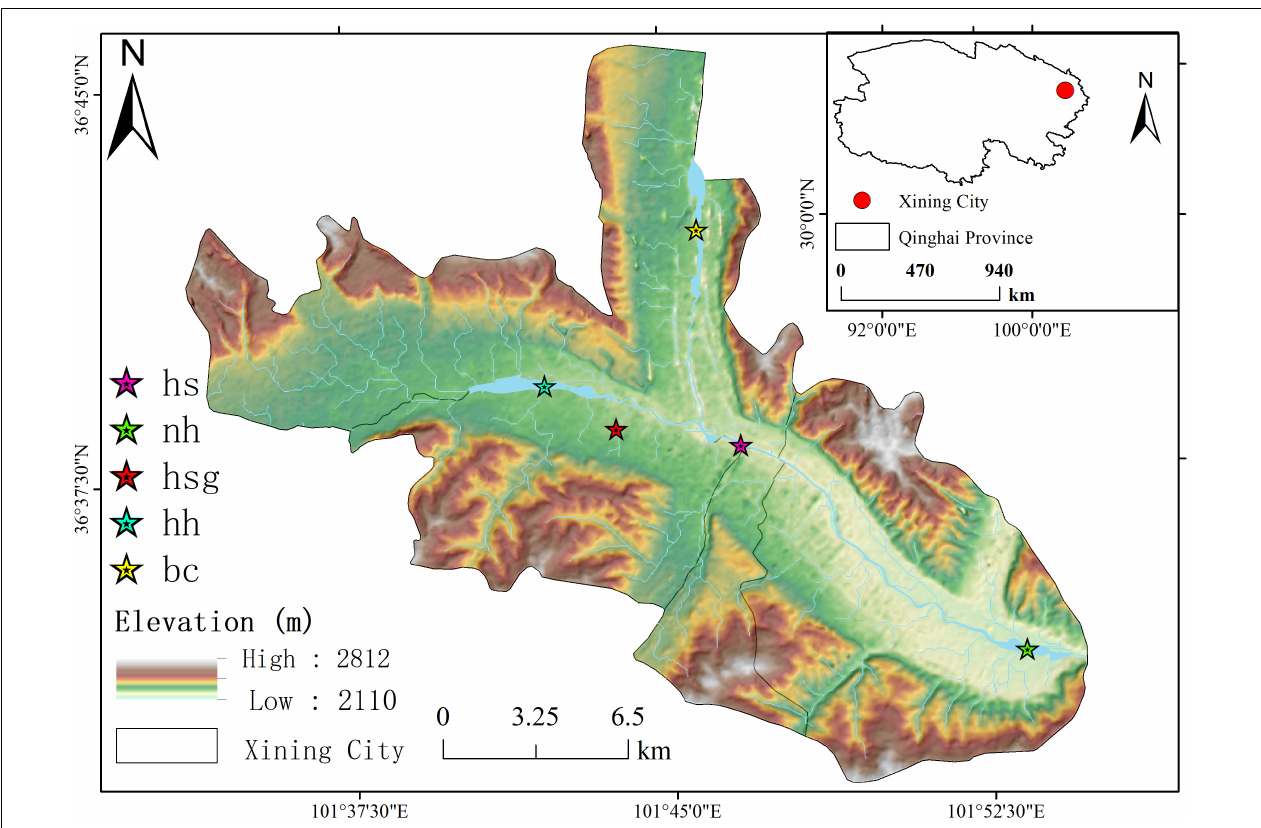
FIGURE 1 | The location of the Huangshui National Wetland Park. Haihu wetland (36 ◦ 38 (cid:48) 57 (cid:48)(cid:48) –36 ◦ 39 (cid:48) 29 (cid:48)(cid:48) N, 101 ◦ 40 (cid:48) 24 (cid:48)(cid:48) –101 ◦ 43 (cid:48) 24 (cid:48)(cid:48) E). Huoshaogou wetland (36 ◦ 38 (cid:48) 15 (cid:48)(cid:48) –36 ◦ 39 (cid:48) 01 (cid:48)(cid:48) N, 101 ◦ 42 (cid:48) 40 (cid:48)(cid:48) –101 ◦ 43 (cid:48) 55 (cid:48)(cid:48) E). Beichuan wetland (36 ◦ 40 (cid:48) 40 (cid:48)(cid:48) –36 ◦ 43 (cid:48) 32 (cid:48)(cid:48) N, 101 ◦ 45 (cid:48) 41 (cid:48)(cid:48) –101 ◦ 46 (cid:48) 11 (cid:48)(cid:48) E). Ninghu wetland (36 ◦ 34